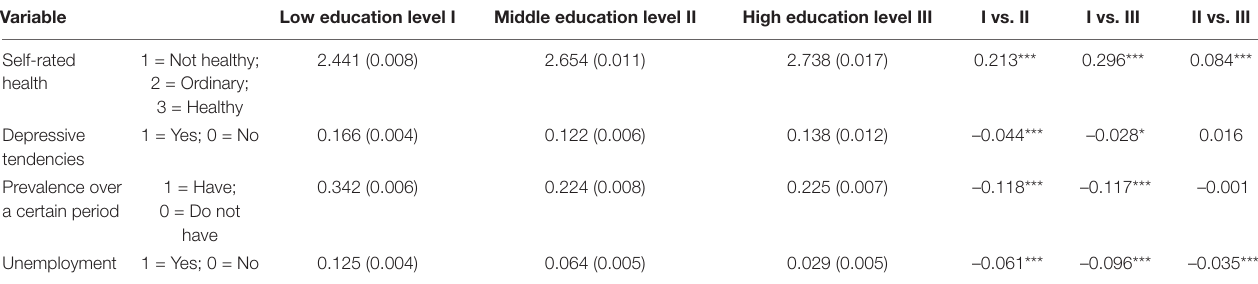
TABLE 2 | Underemployment status and health differences in workers across different education